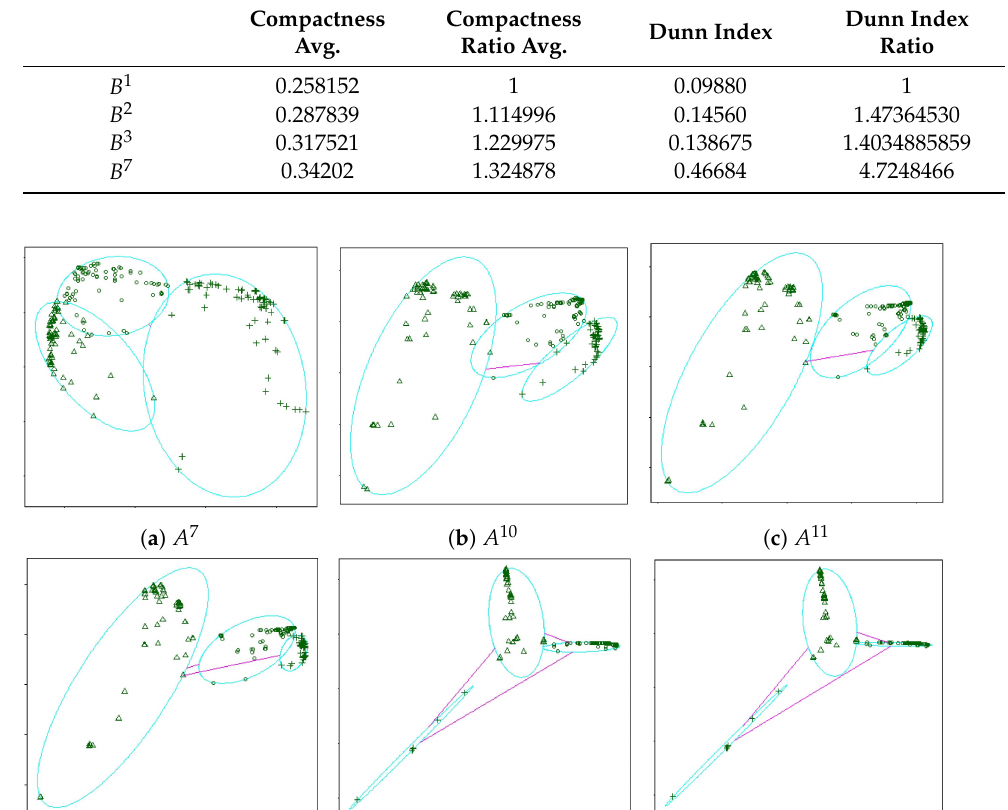
Figure 6. Compactness, Donn index and Sum of Squared errors. Iris dataset. Table 3. Compactness, Donn index as we increase ultrametricity. Iris dataset.